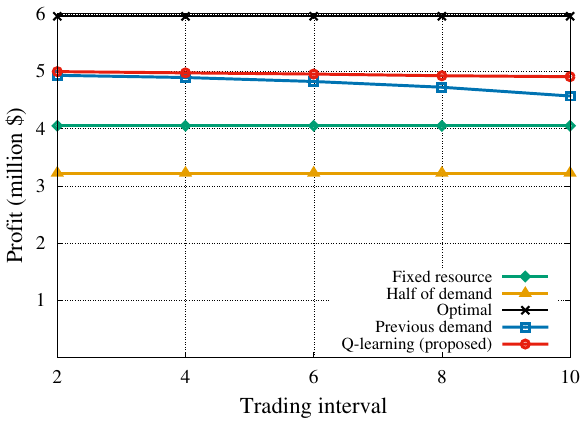
Figure 5. Profit with respect to the trading